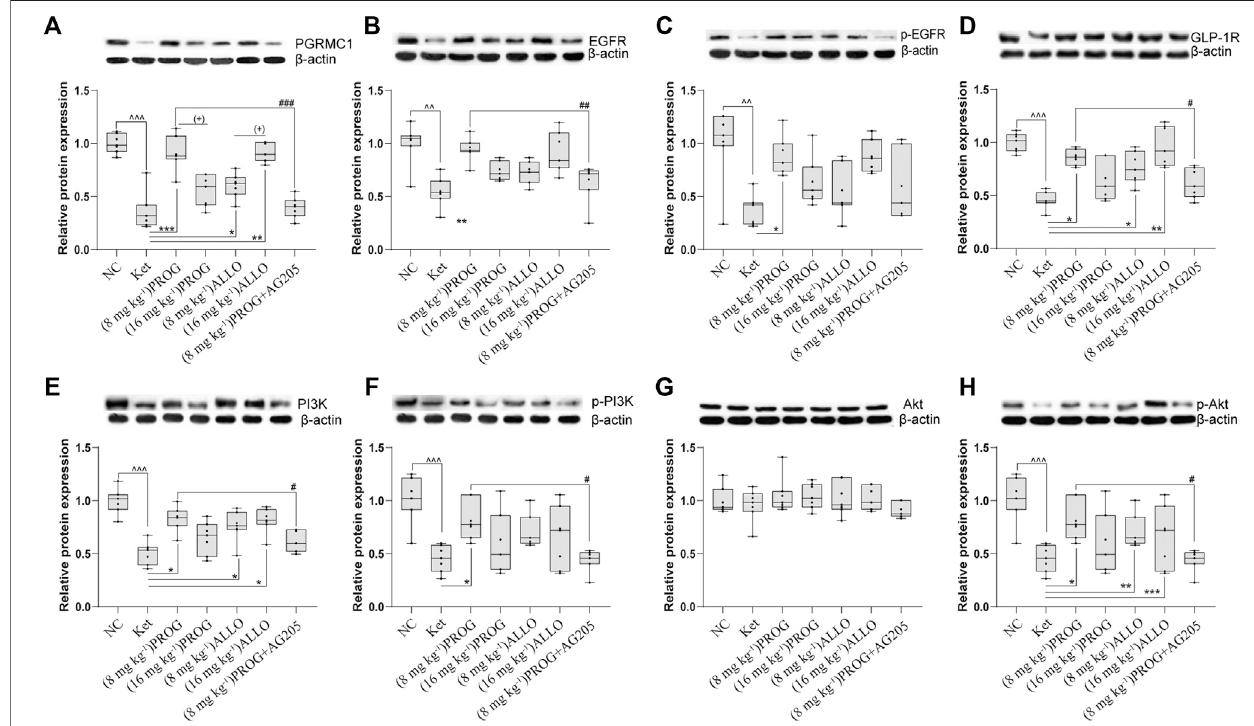
FIGURE 3 | Basal protein expression pro fi le of the PGRMC1/EGFR/GLP-1R/PI3K/Akt pathway in the hippocampus. (A) PGRMC1, (B) EGFR, (C) p -EGFR, (D) GLP-1R, (E) PI3K, (F) p-PI3K, (G) Akt, (H) p-Akt.Dataareexpressed asmean ± SD, n (cid:2) 7foreachexperimental group. ^ p < 0.05, ^^ p < 0.01,and ^^^ p < 0.001forKetvs.NC. * p < 0.05, ** p < 0.01 and *** p < 0.001 for add-on of PROG and ALLO vs. Ket. # p < 0.05, ## p < 0.01 and ### p < 0.001 for PROG (8 mg kg − 1 )+AG205 vs. PROG (8 mg kg − 1 ). + p < 0.05, ++ p < 0.01 and +++ p < 0.001 for PROG (16 mg kg − 1 ) vs. PROG (8 mg kg − 1 ) and ALLO (16 mg kg − 1 ) vs. ALLO (8 mg kg − 1 ). The